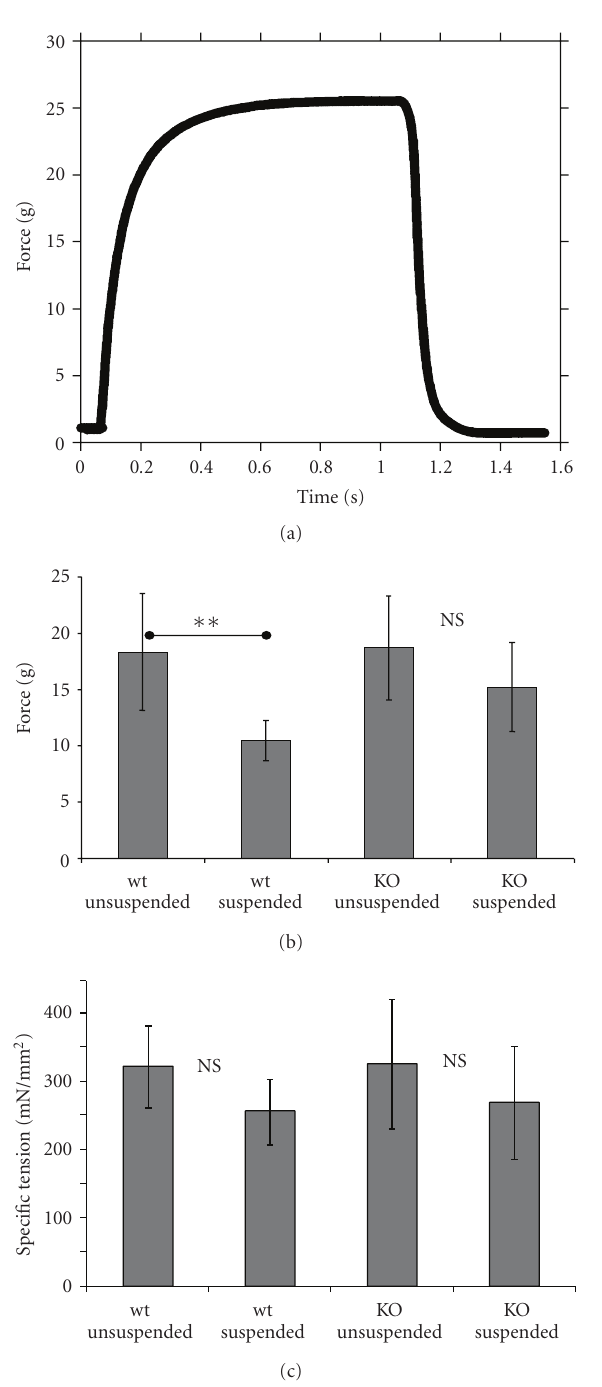
Figure 4: Tetanus Contraction. We stimulated the soleus muscle to a maximum tetanic contraction at a stimulus frequency of 150Hz. (a) Example of a tetanus of a wt mouse. (b) Mean results of wt and MuRF1-KO mice who had been suspended or unsuspended. There is a significant di ff erence when comparing the absolute peak tetanic force. The data from wt unsuspended mice are significantly di ff erent from those of wt suspended mice. However, there is no significant force reduction between the KO unsuspended and the KO suspended mice. (c) Specific tetanic force comparisons did not reveal a significant di ff er- ence.